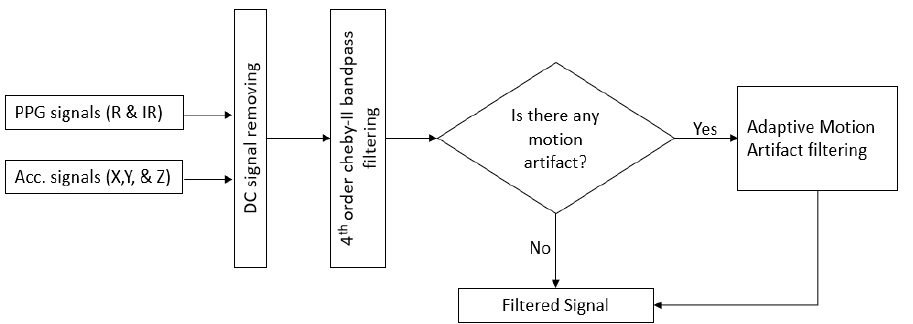
Figure 5. Samples of PPG signals for stressed and non − stressed conditions.